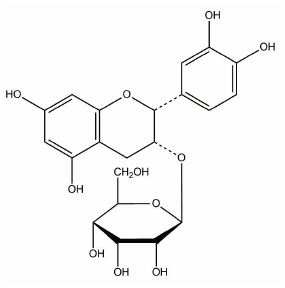
Figure 1. Structure of ( − )-epicatechin-3- O - β - D -allopyranoside